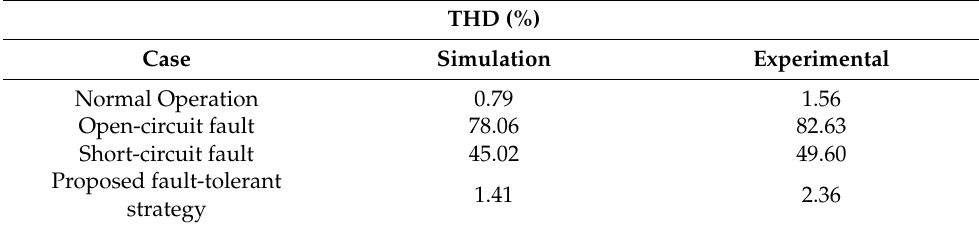
Table 5. Harmonic Spectrum Results of Load Currents in phase-A.